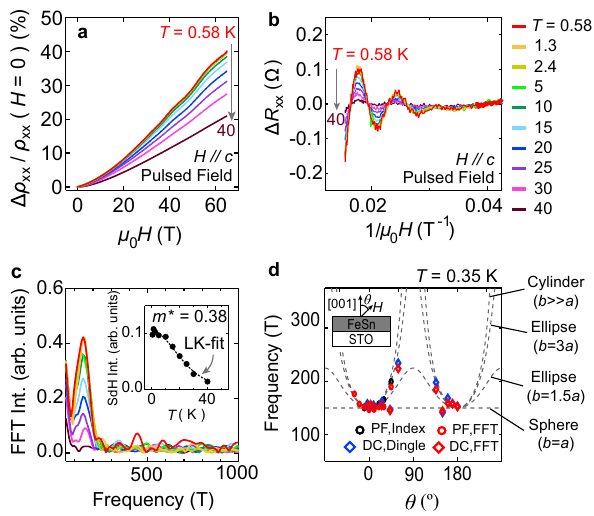
Fig. 5 Electrical transport at high magnetic fi eld. a High- fi eld magnetoresistance of FeSn/STO at different temperatures. b Shubnikov-de Haas (SdH) oscillations at different temperatures, extracted from a . c Fast Fourier Transform (FFT) of the SdH oscillations in b . The inset shows the temperature-dependent SdH oscillation amplitudes (marker) and their fi t to Lifshitz-Kosevich (LK) formula (dashed line), from which the effective mass of m ⋆ = 0.38 m 0 was extracted. d Field angle-dependent SdH oscillation frequencies. Different fi tting methods were applied to data sets from experiments in two different magnet systems (see Supplementary Note 19). The overlaid dashed lines denote expected Fermi surface cross-sections assuming different Fermi pocket ellipticity. a and b , respectively, are the minor and major axes of the ellipse, also corresponding to the Fermi wavevectors along the ab -plane and the c axis of